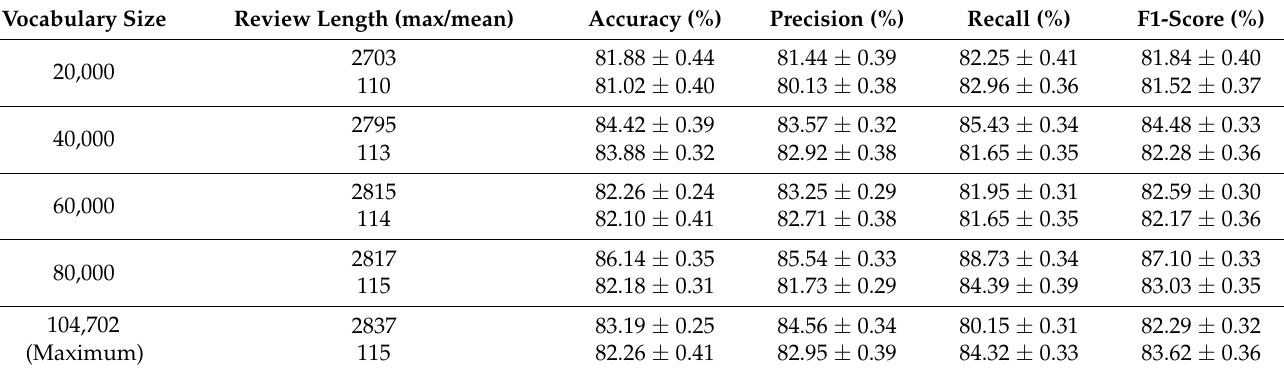
Table 5. Mean and standard deviation for classification performance on the different vocabulary sizes and reviews length for the CNN–BiLSTM hybrid model.